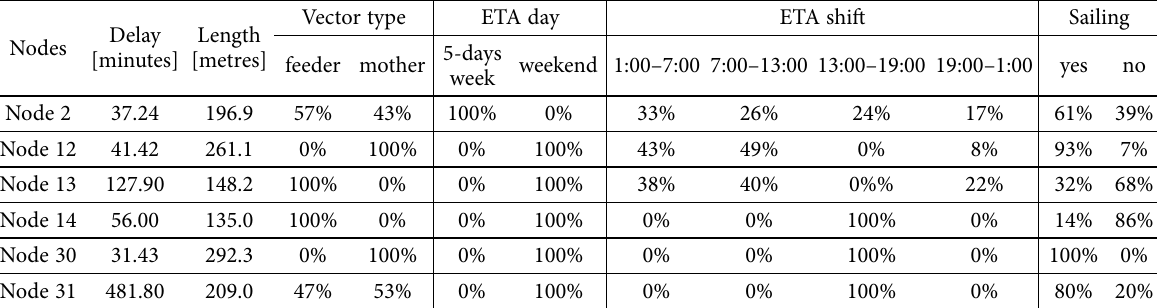
Table. Final nodes